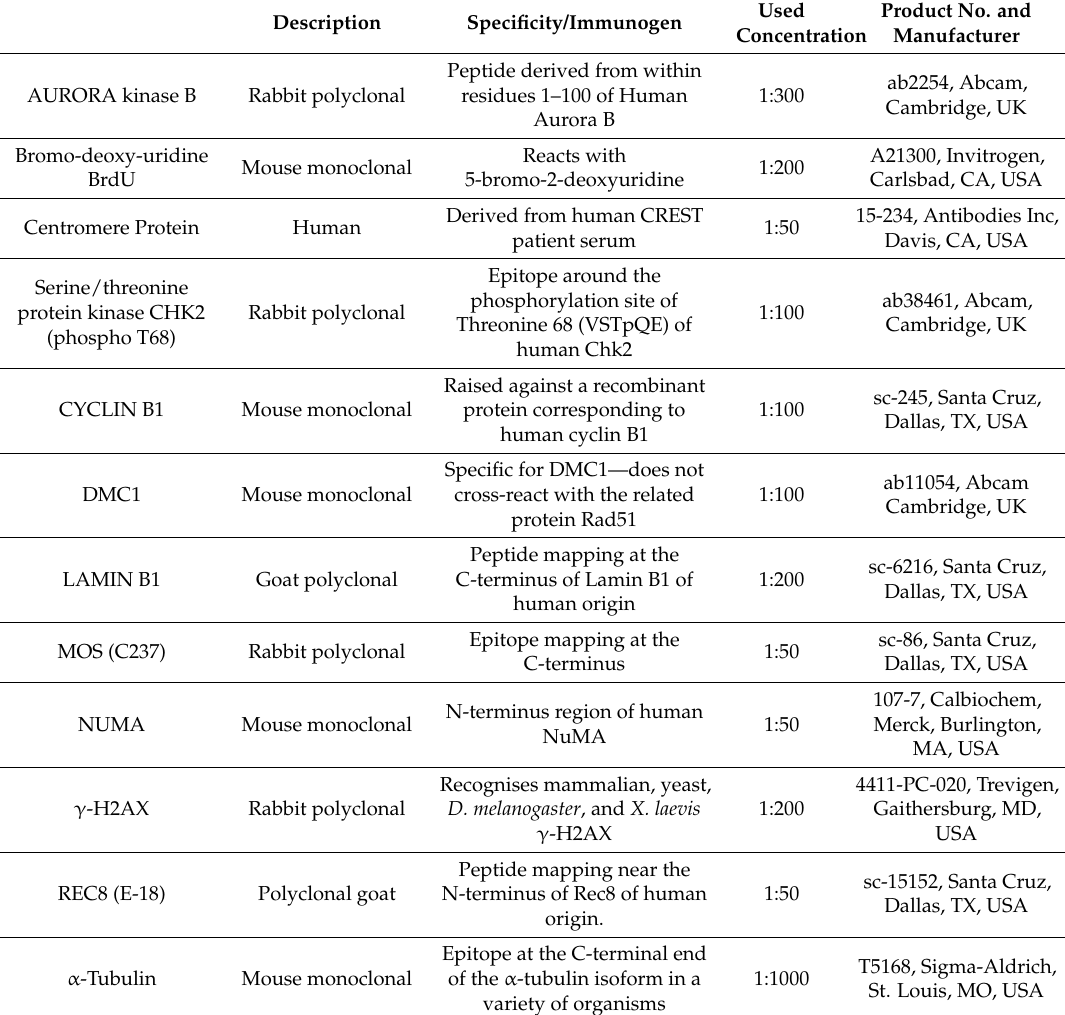
Table 1. Primary antibodies and their